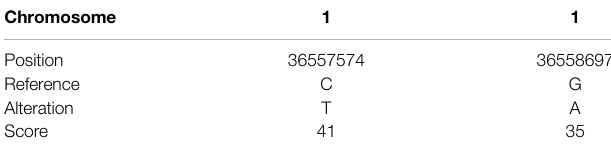
TABLE 3 | The predictive result of